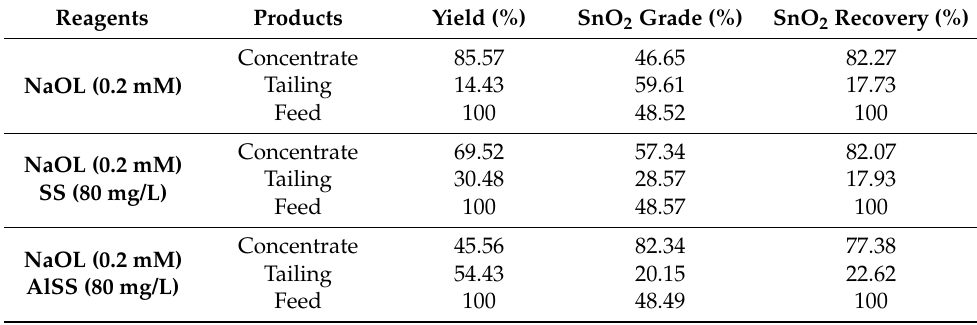
Table 1. Flotation results of mixed minerals (pH = 8.5, NaOL = 0.2 mM, AlSS = 80 mg/L).